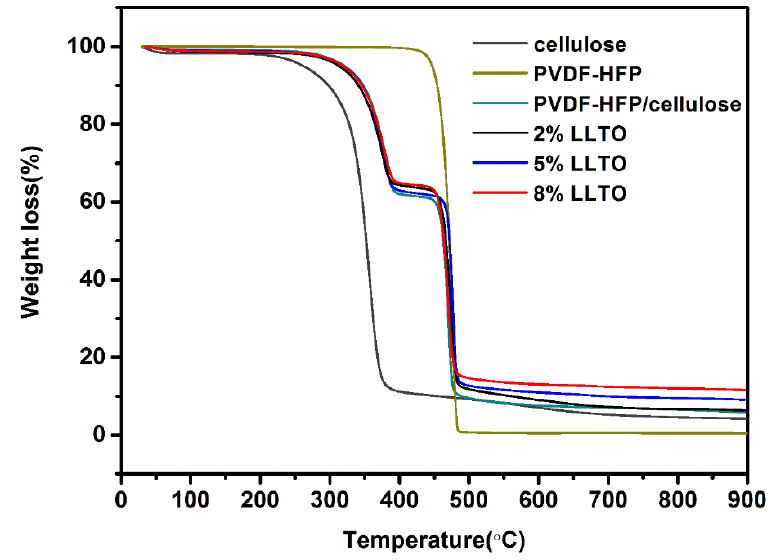
Figure 3. TGA curves of PVDF ‐ HFP/cellulose and LLTO composite nanofibrous membrane.